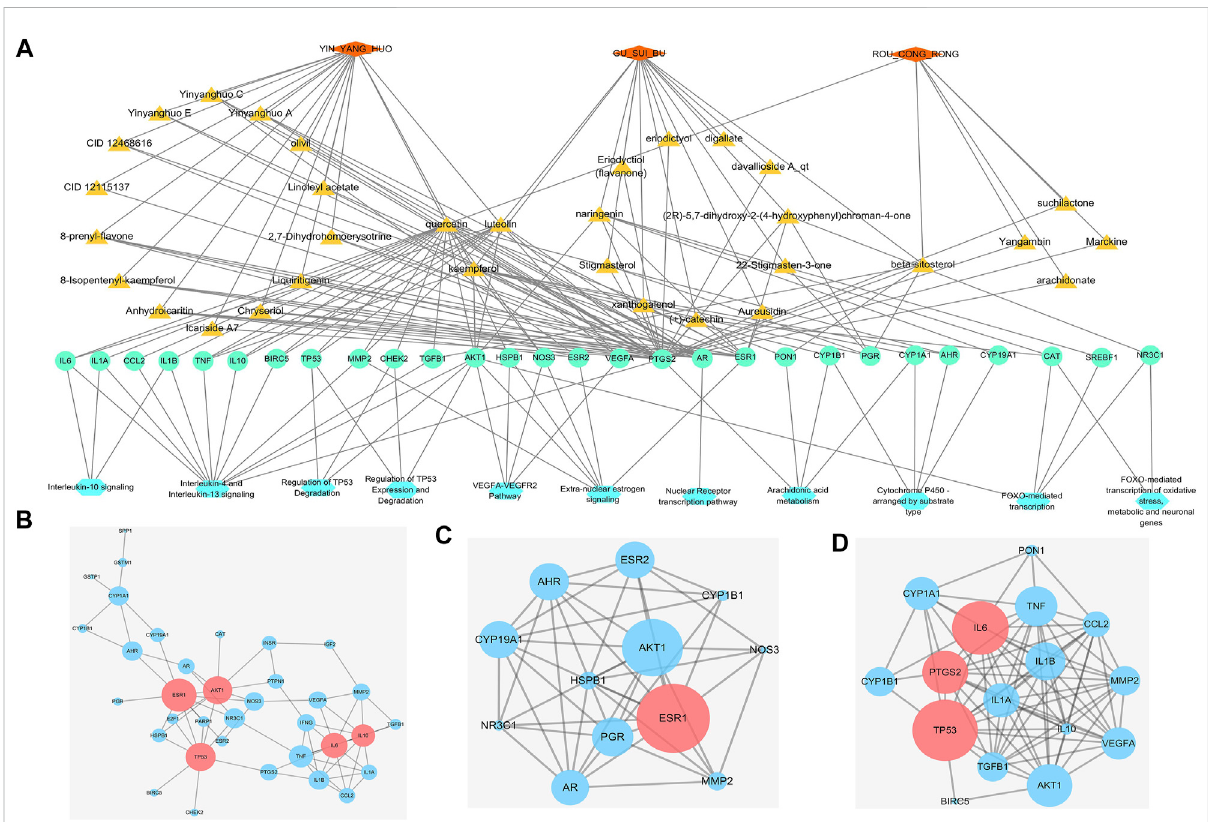
FIGURE 3 Interactive networks of infertility treatment targets based on databases (A) “ Herbs-Compounds-Targets-Pathways ” network. Orange diamond: TCM; dark yellow triangle: active compound; green circle: gene; blue hexagon: pathway (B) Protein – protein interaction network (PPIN) of 44 WSYR infertility therapeutic targets. Dark pink circle: key targets; blue circle: other targets (C) Hormone-related PPIN based on database targets. Dark pink circle: key targets; blue circle: other targets (D) In fl ammatory immune-regulated PPIN based on database targets. Dark pink circle: key targets; blue circle: other